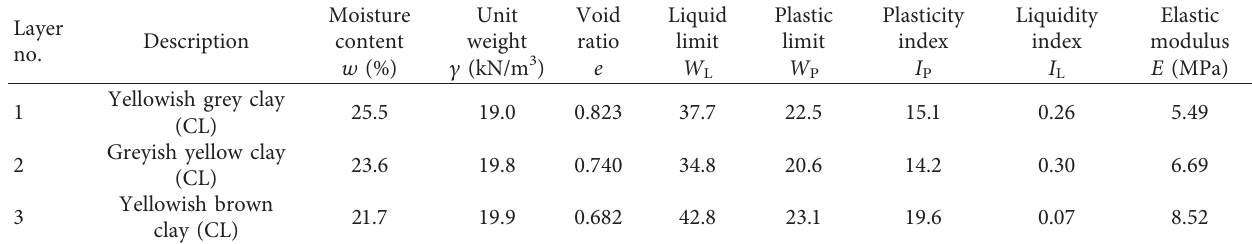
Table 2: The physical properties of the slope soil samples.